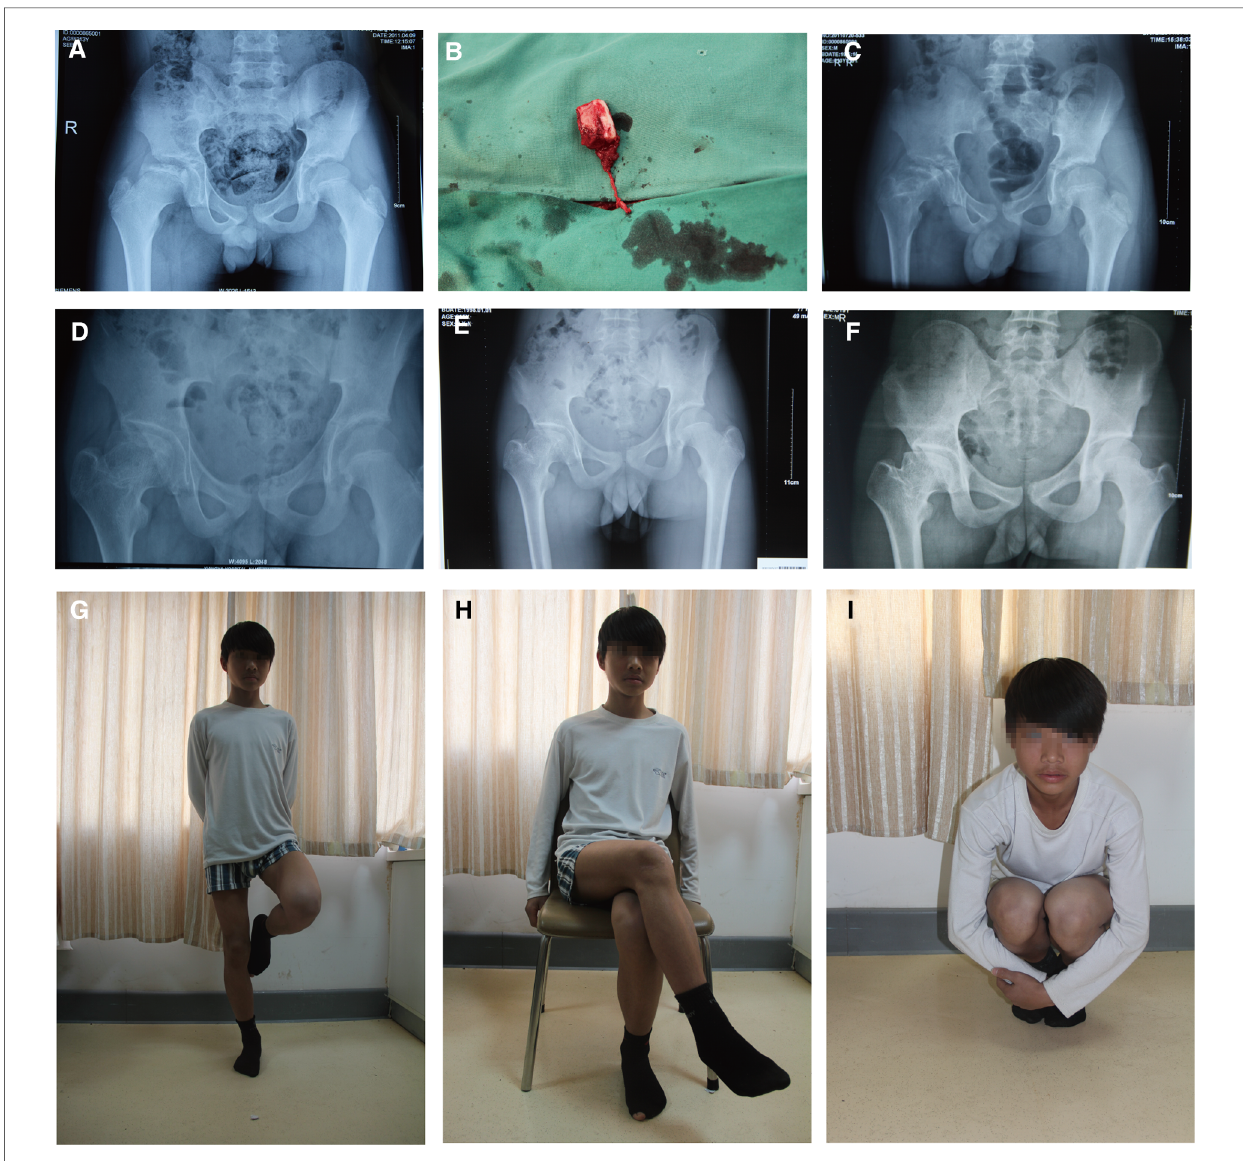
FIGURE 2 A 13-year-old boy underwent a pedicled iliac bone fl ap based on deep circum fl ex iliac vessels to treat LCPD of the right side (lateral pillar grade B/C). ( A ) Preoperative x-ray fi lm. ( B ) The pedicled iliac bone fl ap was harvested. Postoperative AP x-rays at ( C ) 3 months, ( D ) 17 months, ( E ) 24 months, and ( F ) 69 months showed no collapse of femoral heads or narrowing of the hip joint spaces. Hip ( G ) extension, ( H ) external rotation, and ( I ) fl exion showed good recovery. LCPD, Legg – Calvé – Perthes disease; AP,